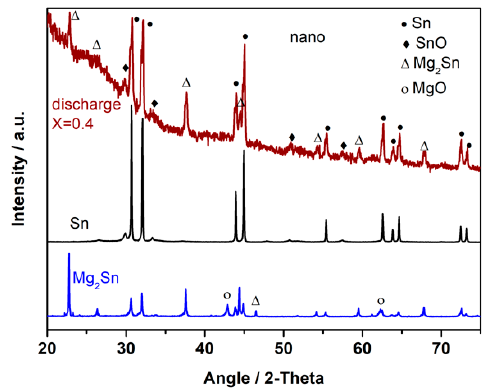
Figure 5. XRD pattern of commercial nano-Sn, and discharged nano-Sn electrode in Mg half-cell at Mg x Sn nominal compositions with x = 0.4 and x = 2.0.